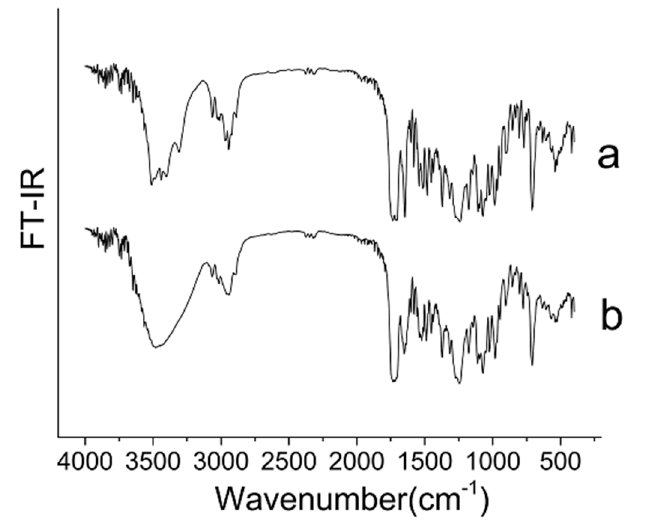
Figure 5. FT–IR spectra (Wavenumber: 400–4000 cm − 1 ) of the samples. ( a ) Raw PTX; and ( b ) PTX crystal powders.